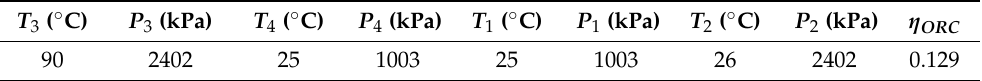
Table 12. ORC design conditions